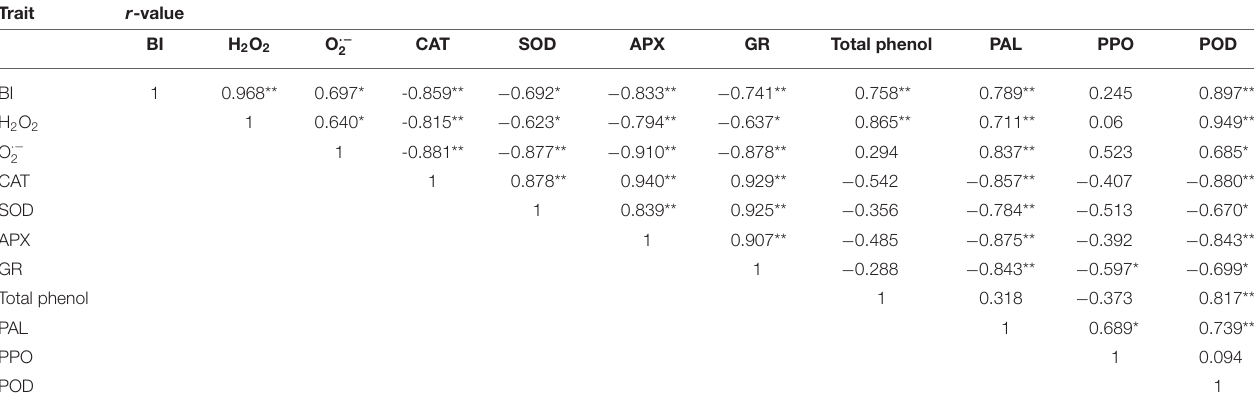
FIGURE 4 | Effects of H 2 S treatment on total phenolic content (A) , PAL (B) , PPO (C) , and POD (D) activities of fresh-cut Chinese water chestnuts during storage at 10 ◦ C for 8 days. Vertical bars represent the standard errors of the means. Different letters (at the same day) mean that they were significantly different (Duncan’s multiple range test, P < 0.05). PAL, phenylalanine ammonia lyase; PPO, polyphenol oxidase; POD, peroxidase.